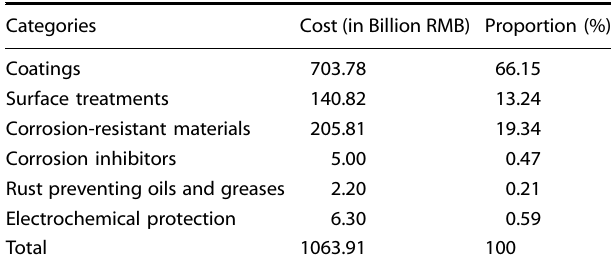
Table 6. The direct costs of corrosion in China in 2014 (Uhlig method)